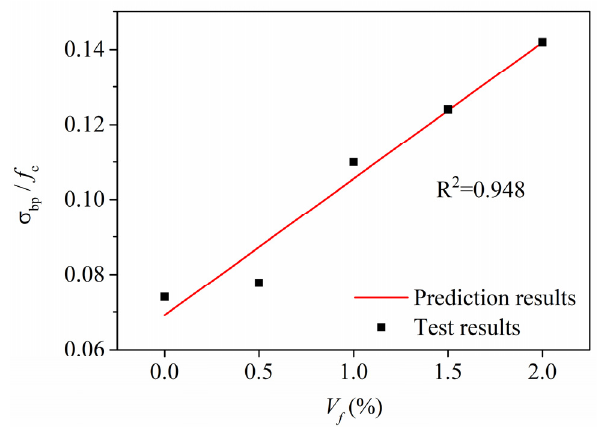
Figure 18. Relationship between σ bp / f c and V f .